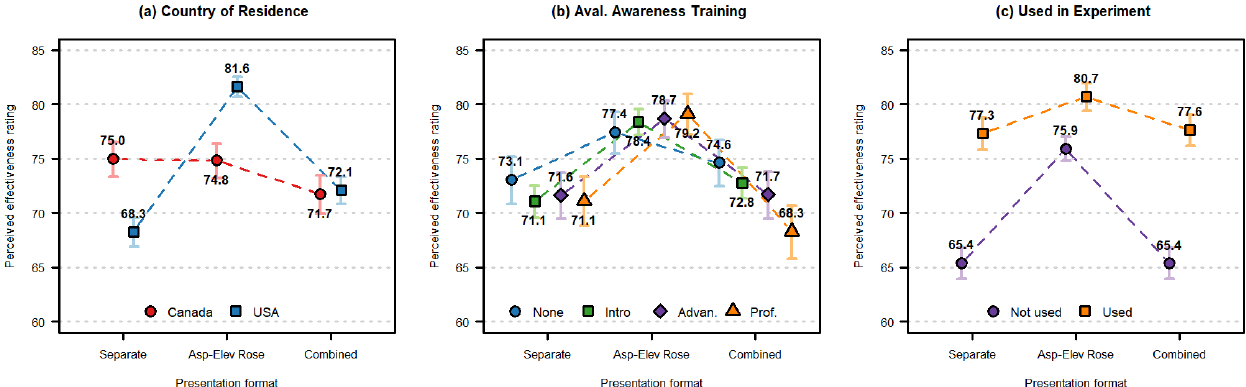
Figure 6. Effects plots illustrating the interaction effects with the presentation format in the perceived effectiveness rating model. Error bars represent 95% confidence intervals for perceived effectiveness calculated from the subsample for the particular parameter